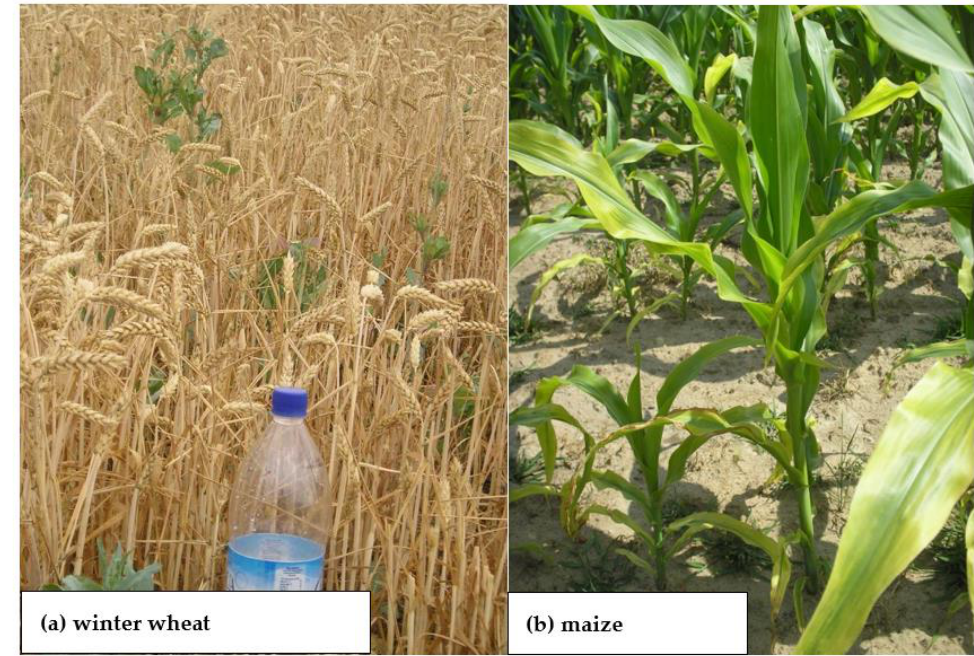
Figure 4. The stunted stature of plants due to potassium deficiency is the primary signal of yield depression in crop plants. (photos by W. Grzebisz).